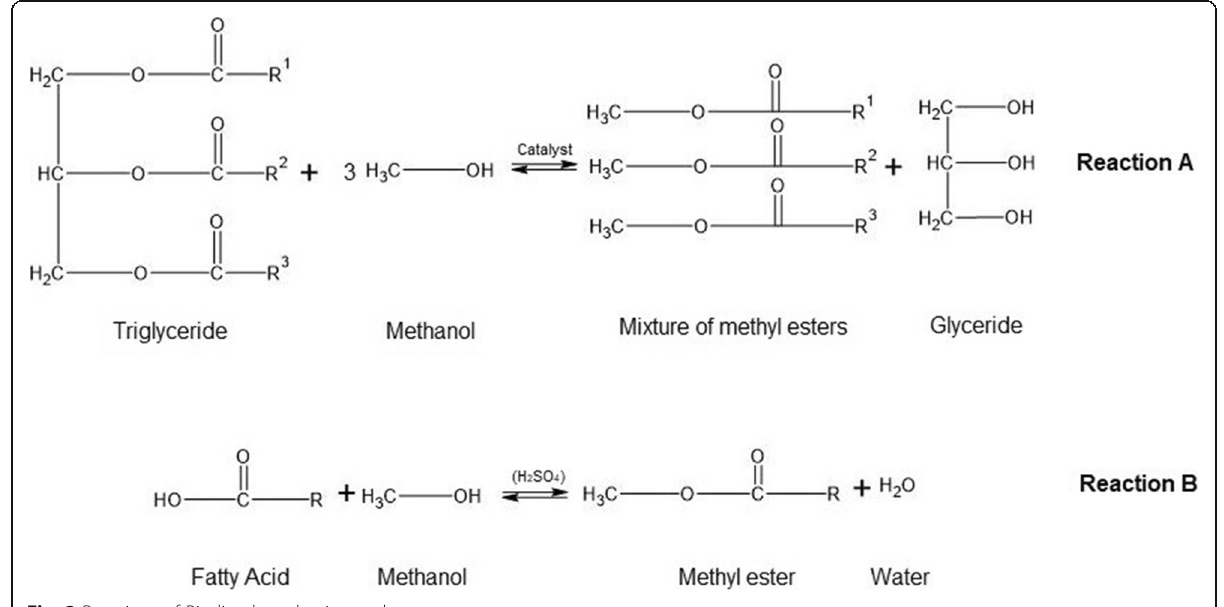
Fig. 3 Reactions of Biodiesel production and pre-treatment